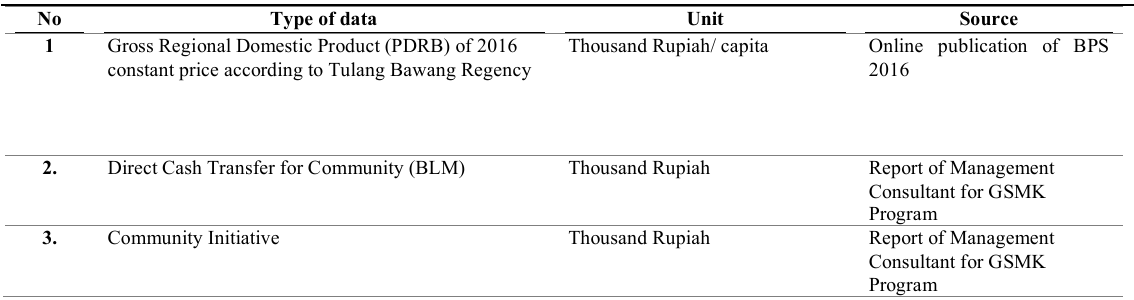
Table 1 : Research Data